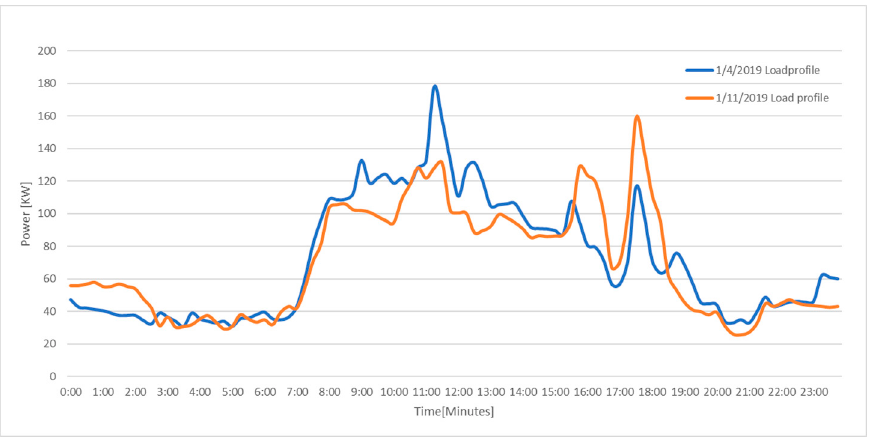
Figure 2. Week-ahead daily load profile.